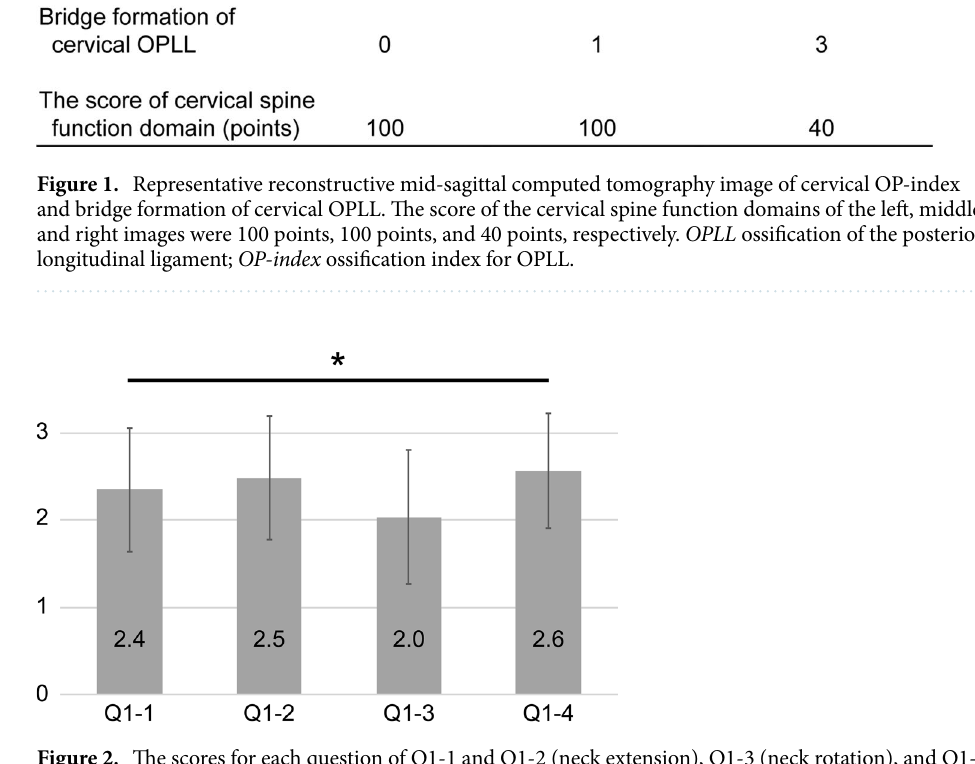
Figure 2. The scores for each question of Q1-1 and Q1-2 (neck extension), Q1-3 (neck rotation), and Q1-4 (neck flexion). The score of Q1-3 was significantly lower than that of the other questions. * p <